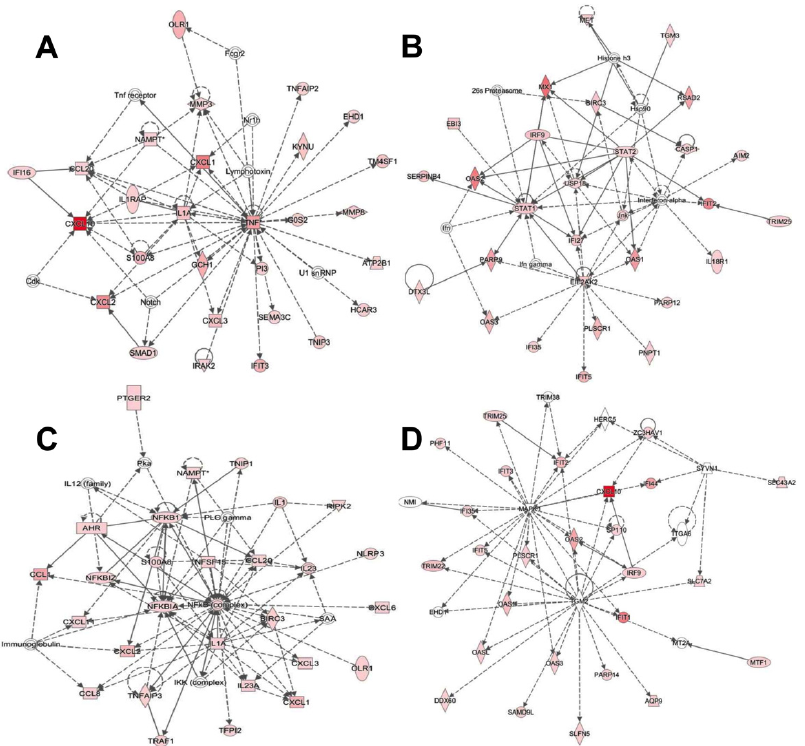
Figure 4. Networks induced by the BCG strains in THP-1-derived macrophages. Networks of func- tional: ( A ) dermatological diseases and conditions, cell-to-cell signaling and interaction, cellular movement; and ( B ) antimicrobial response, inflammatory response, cell signaling related to M.BCG vs. Ctrl. Network of functional: ( C ) inflammatory response, connective tissue disorders, inflamma- tory disease; and ( D ) antimicrobial response, inflammatory response, dermatological diseases and conditions related to P.BCG vs. Ctrl. Color codes: red, overexpressed; green, subexpressed. The color intensity indicates the degree of expression. Encoding form: rectangle—nuclear receptor lig- and-dependent; oval—transcription regulator; rhombus—enzyme; circle—other.